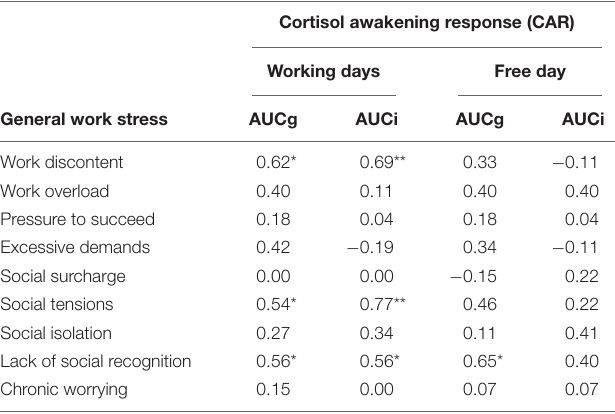
TABLE 1 | The association between general work stress and cortisol awakening response. Cortisol awakening response